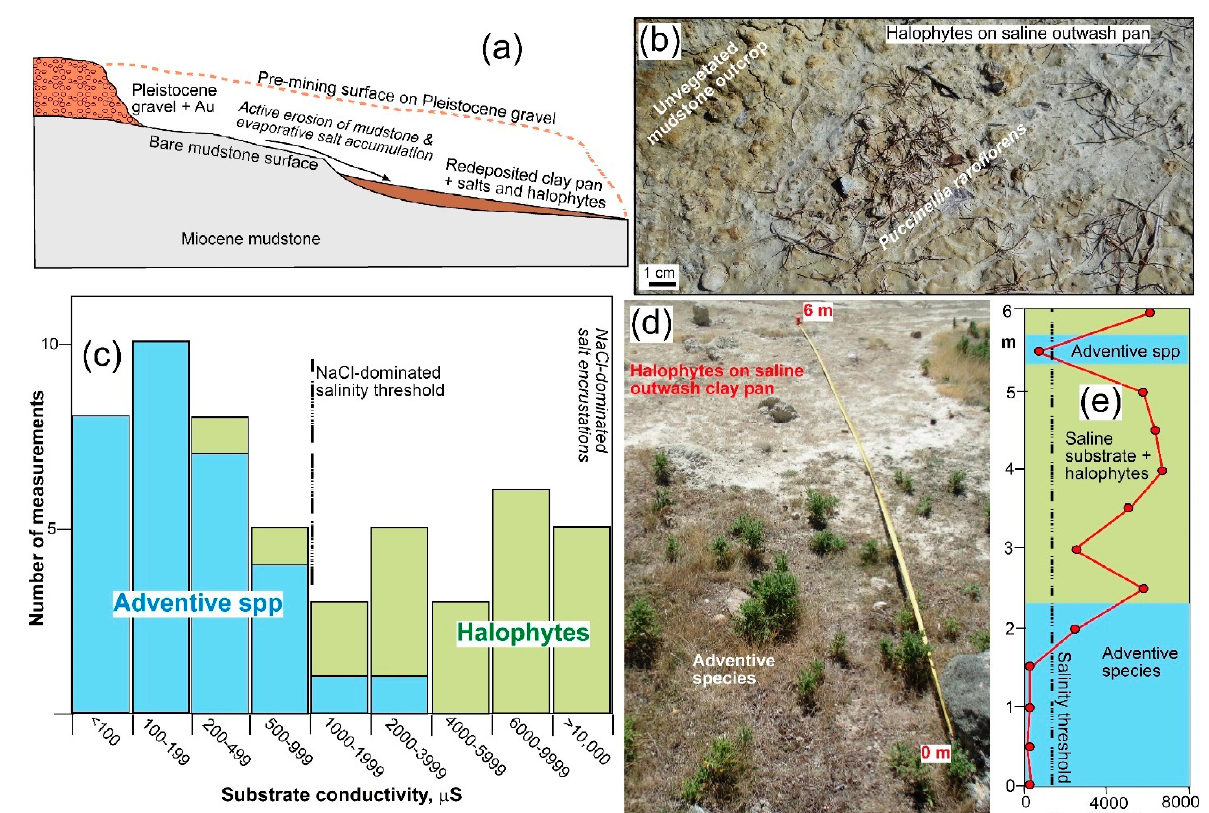
Figure 4. Springvale historic placer gold mine. ( a ) Sketch cross section showing the principal features at present, in relation to the premining topography. ( b ) Photograph of halophyte plants on an active clay outwash pan at the foot of a scarp of Miocene mudstone left by the miners. ( c ) Histogram of EC data from substrates across the site for halophytes and nearby adventive species [23]. ( d ) Photograph of the boundary between vegetation by adventive species and saline clay-rich substrate with abundant halophyte colonisation. ( e ) EC measurements obtained from substrate samples collected 50 cm apart along the taped transect in d.